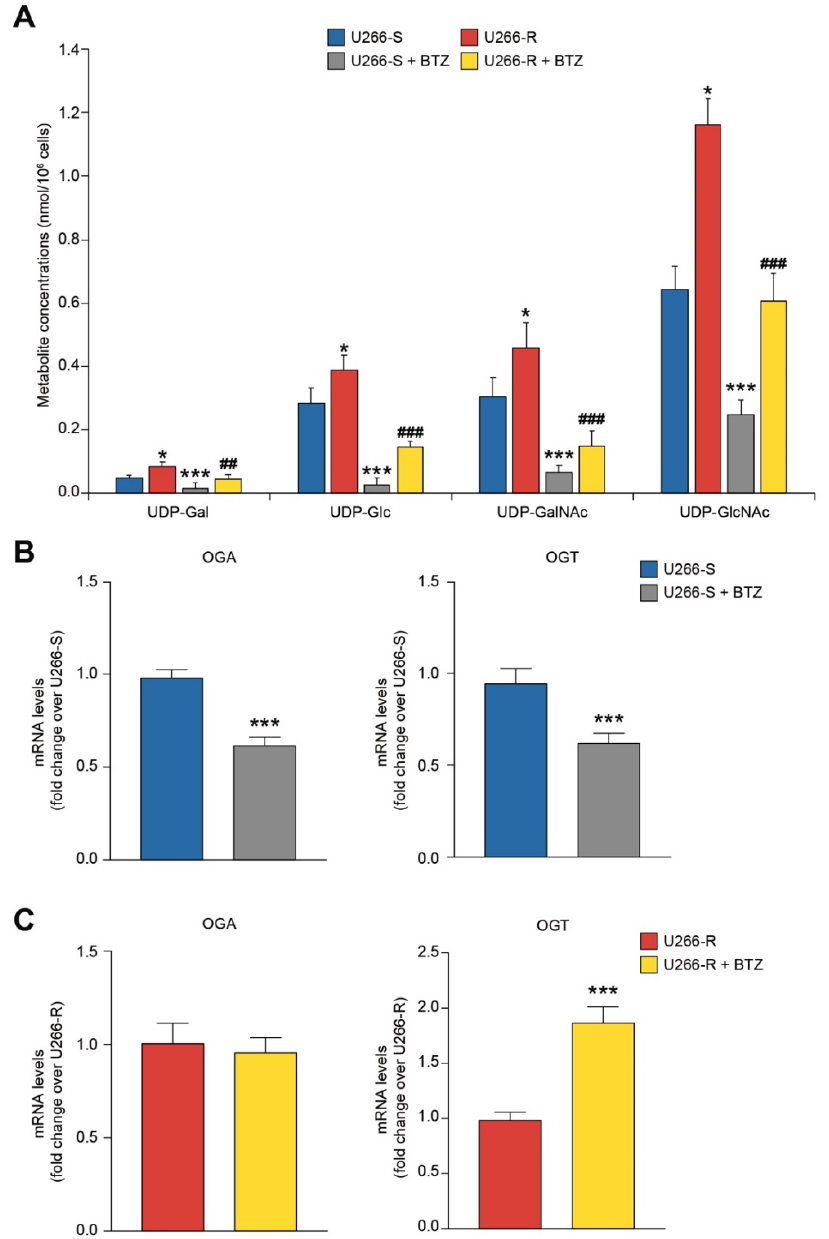
Figure 7. Glycosylated UDP derivatives in U266-S and U266-R after exposure to BTZ. ( A ) Metabolite concentrations are expressed as nmol per 10 6 cells in U266-S and U266-S + BTZ and in U266-R and U266-R + BTZ. Data are shown as mean ± SEM of n = 4 biological replicates; * p -value < 0.05 and *** p -value < 0.001 versus U266-S; ## p -value < 0.01 and ### p -value < 0.001 versus U266-S + BTZ. ( B , C ) mRNA levels of OGA and OGT in untreated U266-S and U266-S + BTZ ( B ) and in U266-R and U266-R + BTZ ( C ); data are fold changes over untreated U266-S ( B ) or over untreated U266-R ( C ) and expressed as mean ± SEM of n ≥ 3 biological replicates; *** p -value < 0.001 versus U266-S or U266-R.